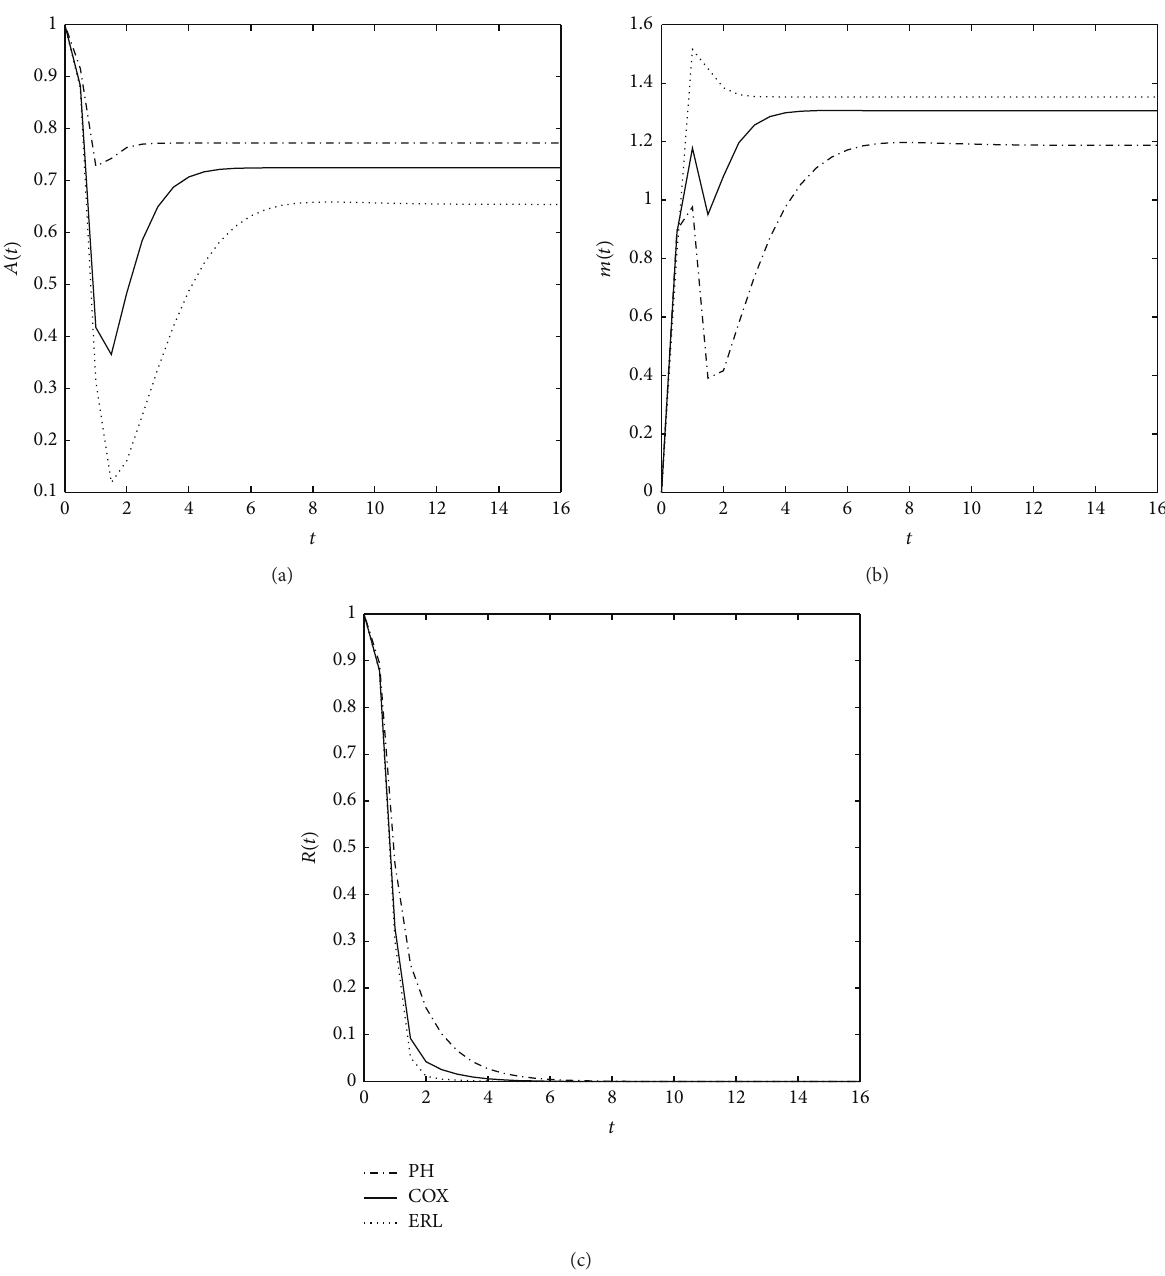
Figure 2: Different vacation time distributions on the system reliability